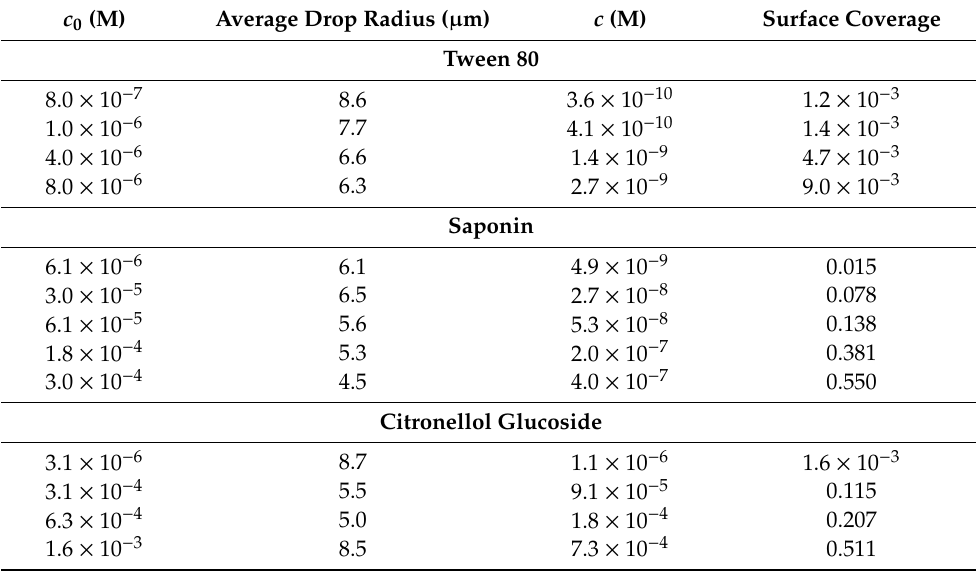
Table A1. Depleted concentrations of the continuous phase ( c ) and the corresponding surface coverages of the droplets after emulsification. c 0 is the concentration of the aqueous solution before